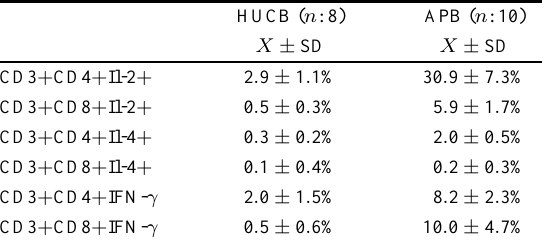
T-cell subset analysis. The cytokine-producing T lymphocytes HUCB and APB were further characterized according to the expres- sion of CD4 and